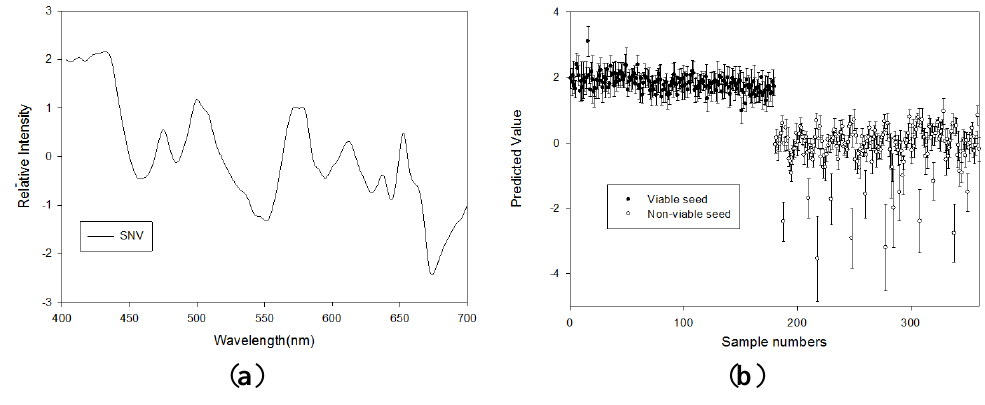
Figure 7. ( a ) Regression coefficients of the PLS-DA model, and ( b ) the PLS-DA prediction results obtained using SNV to discriminate between viable and nonviable pepper seeds based on the reflectance spectra under RGB LED (400–700